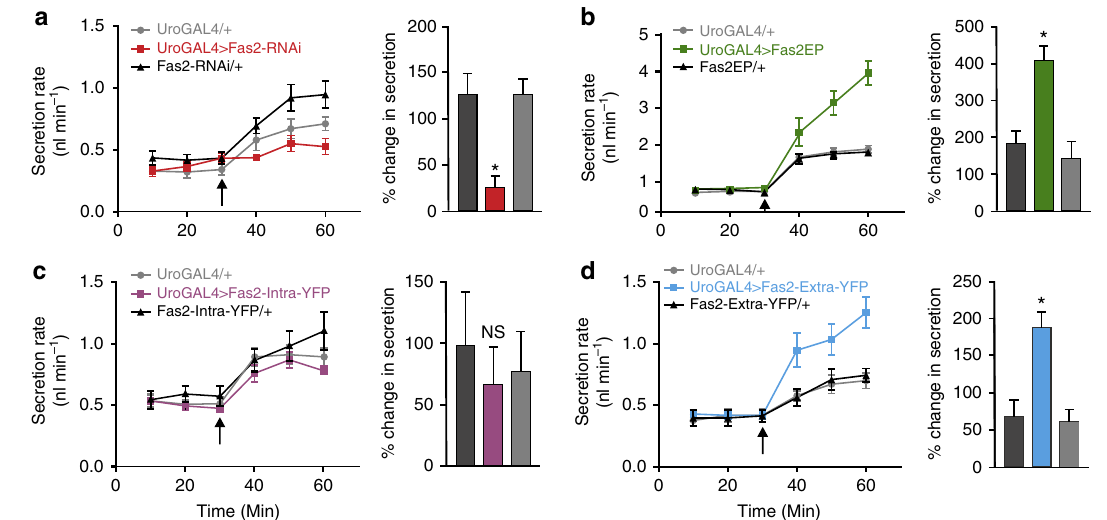
Figure 5 | Genetic manipulation of Fas2 impacts renal function. ( a ) Knock down (red) of Fas2 results in a significant reduction, while ( b ) overexpression (green) of Fas2 causes a significant increase, in cAMP-stimulated rates of fluid secretion compared with parental controls (*, one-way ANOVA, P o 0.05). ( c ) Overexpression of only the Fas2 intracellular domain (magenta) has no significant effect on the cAMP-induced secretion rates (NS, one-way ANOVA, P o 0.05), while ( d ) overexpression of the extracellular domain alone (blue) significantly increased (*, one-way ANOVA, P o 0.05) stimulated fluid secretion rates compared with parental lines. Arrows indicate point of cAMP (10 (cid:2) 4 M) addition. Data are expressed as mean ± s.e.m. of N ¼